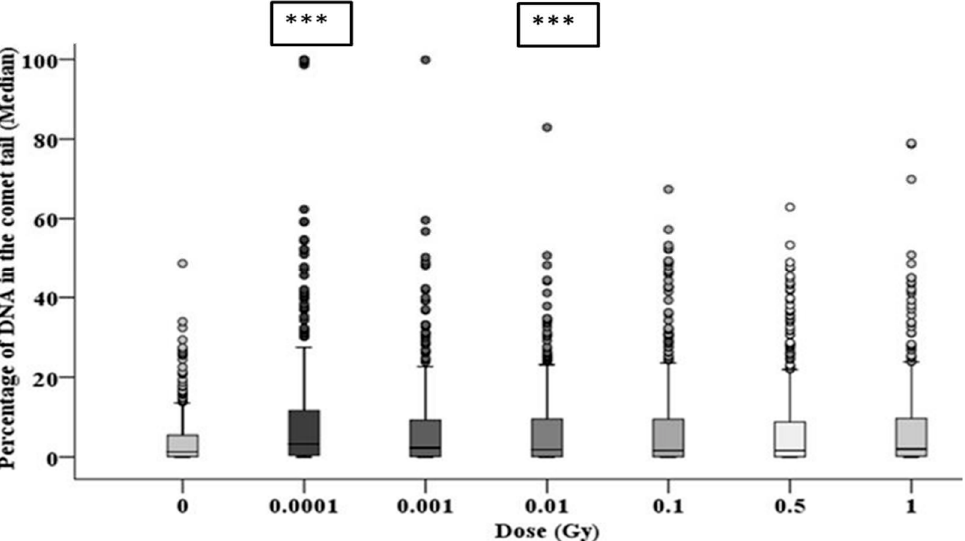
Figure 9. The delayed DNA damage in the progeny of alpha-particle irradiated cells following 20 population doublings determined using the comet assay. Panel A shows the variation in median values as a function of dose for 1000 cells from two parallel but separate experiments. Panel B exhibits the delayed DNA damage distribution in alpha-particle irradiated cells (*** = p ≤ 0.001).